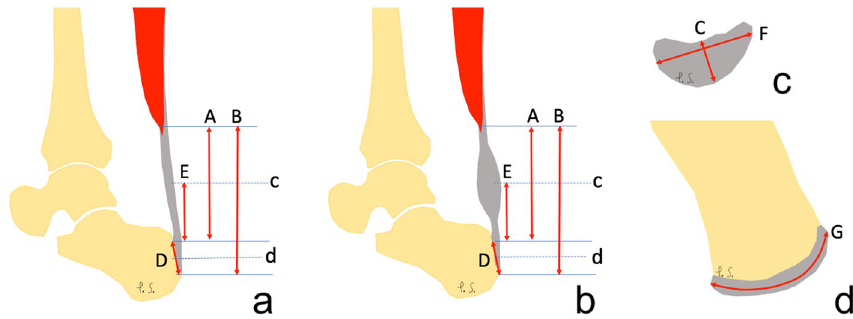
Figure 1. Dimensions of the Achilles tendon. ( a ) and ( b ) sagittal section, ( c ) and ( d ) transverse section. Section c was made at level E. Section d was made in the middle of distance D. A, B, C, D, E and F – dimensions of the Achilles tendon, as explained in the Material and